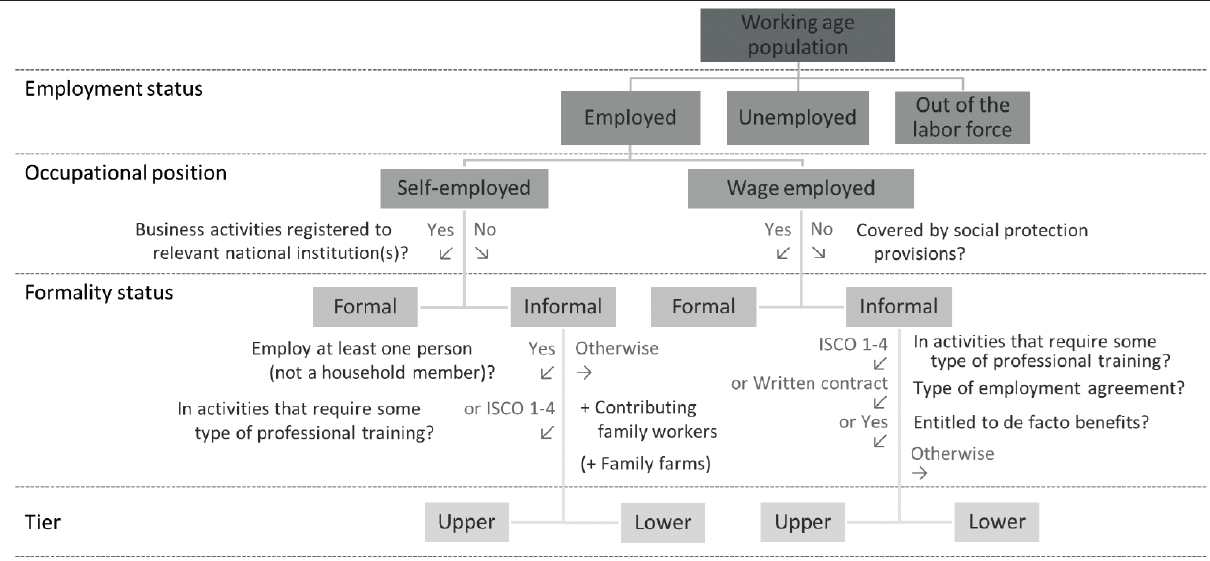
Figure 1 Work status